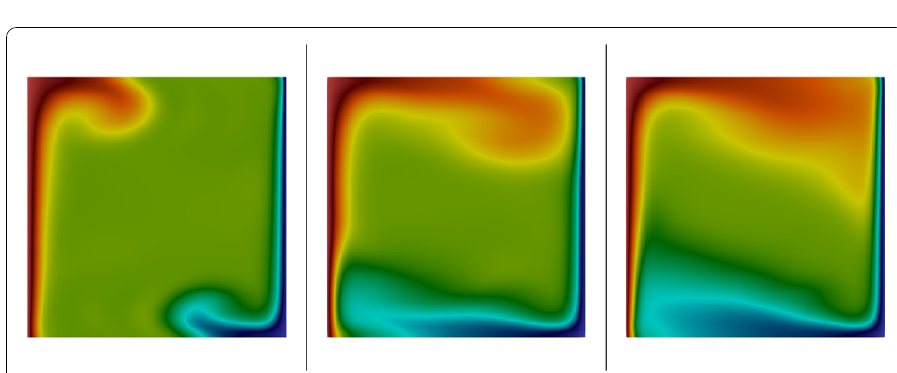
Fig. 2 ROM temperature contours at t = 1, t = 2, and t = 3 s for the 2D differentially heated cavity